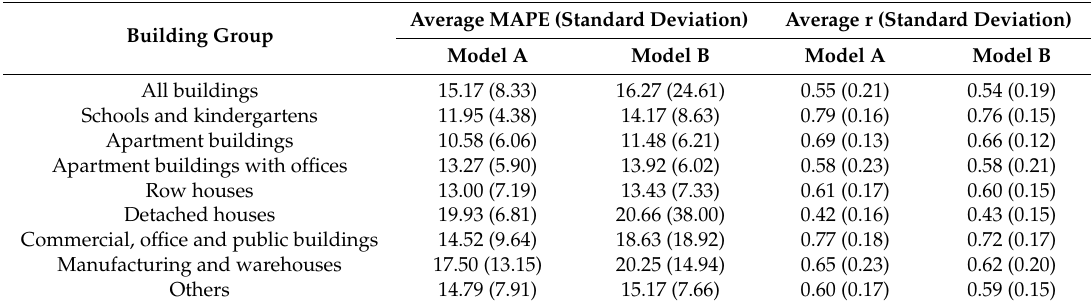
Figure 5. Distribution of the hourly modelling error for the 48-h total heat demand forecast with all ten validation data sets: ( a ) modelling error (model output-measured); ( b ) histogram of the modelling error (white bars) with normal distribution fit (black line); ( c ) normal probability plot for modelling errors. Table 4. The average MAPE and r for 48-h heat demand forecast with 10 validation data sets in different building